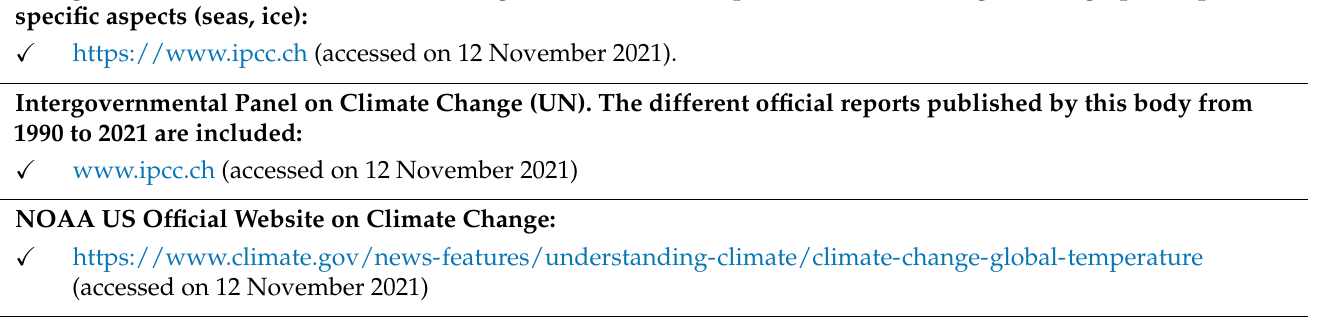
Table A2. Resources and Teaching Materials for Teachers and Students (International